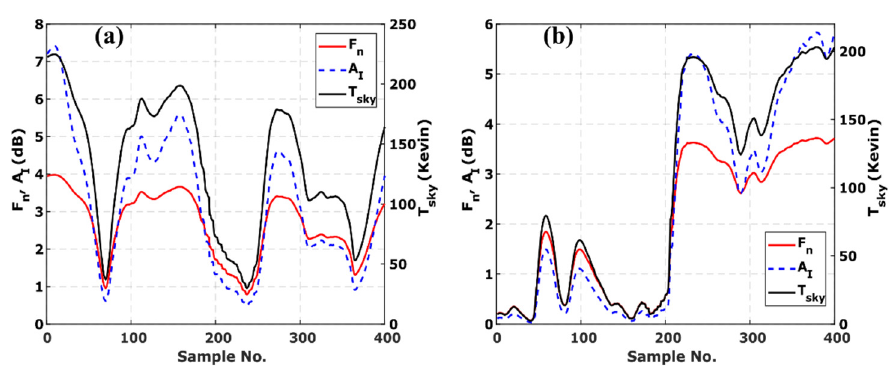
Figure 4. The plots of F n (red line), A I (blue dashed line) and T sky (black line) over the 400 samples during the overpass of the satellite. Panel ( a ) and panel ( b ) are for the receivers located at 40 km and 60 km, respectively.